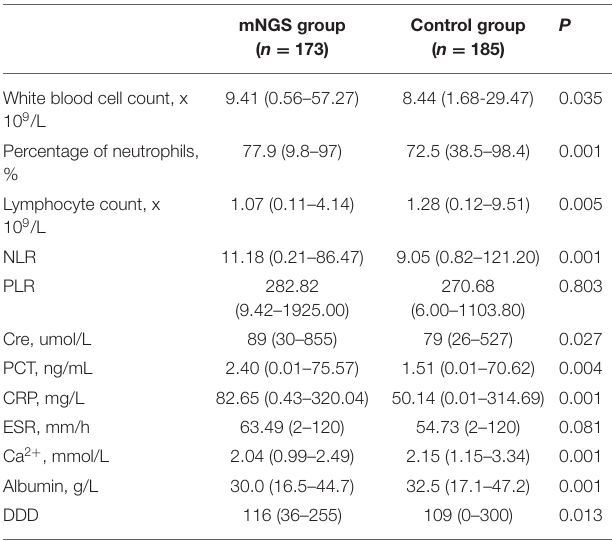
TABLE 2 | Laboratory findings of